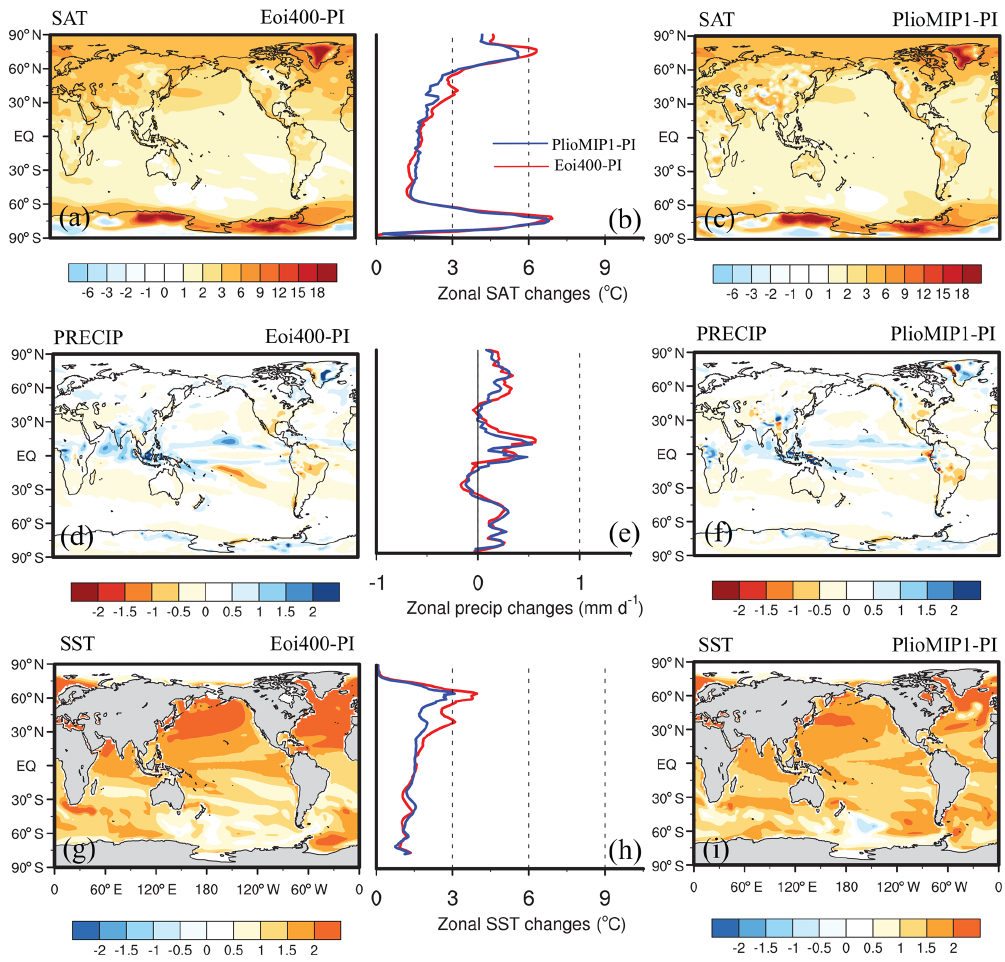
Figure 2. Anomalies of mean annual SAT (a, c) , mean annual precipitation rates (d, f) , and mean annual SST ( g, i ) for PlioMIP 2 (Eoi400) and PlioMIP 1 conducted with IPSL-CM5A in comparison with the associated pre-industrial control experiment. Panels (b) , (e) , and (h) represent the zonal mean of related anomalies (red lines for Eoi400, blue lines for PlioMIP